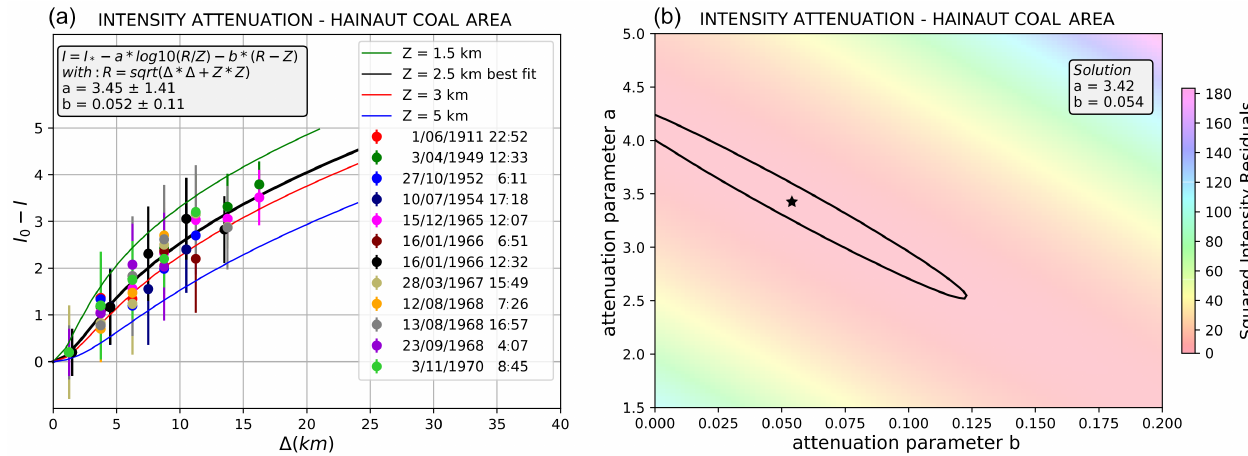
Figure 5. (a) Fitting the intensity dataset of 12 calibration earthquakes to Eq. (1) to determine a and b attenuation parameters and the focal depth considering a uniform depth for all events. (b) Least-squares fitting by sampling the a and b intensity parameters space: the solution is represented by the star, and the black ellipse shows the limits of the 0.95 confidence region. Table 3. Depth evaluation of calibration earthquakes used for attenuation modelling. I 0 : epicentral intensity; Z : depth; b : attenuation param- eter b ; step: length of distance bin in kilometres; n : number of distance bins. 1 First step of the analysis in which parameter a is held constant at a value of 2.80; 2 second step of the analysis. ∗ Earthquake not included in the attenuation modelling but used for verifying the